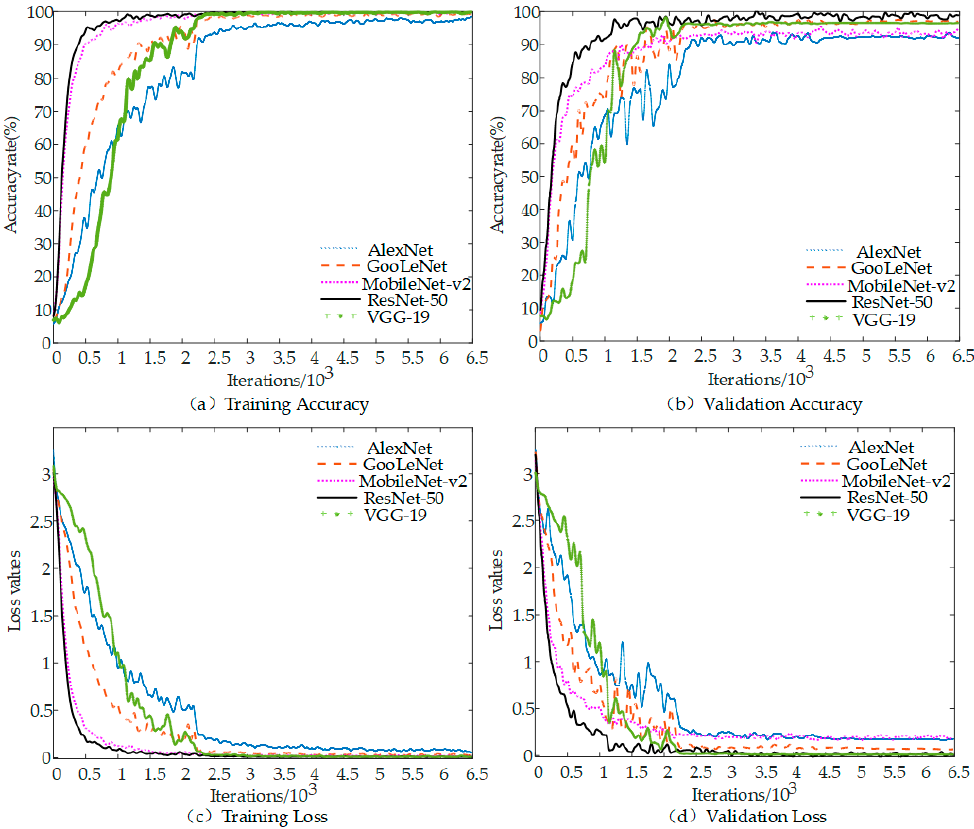
Figure 8. Comparison of training results between ResNet-50 and other CNN models: ( a ) training accuracy; ( b ) validation accuracy; ( c ) training loss; and ( d ) validation